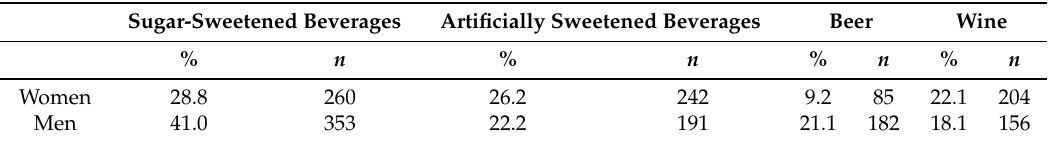
Table 3. Proportion of participants consuming sugar-sweetened beverages, artificially sweetened beverages, beer, and wine on one and/or both recall